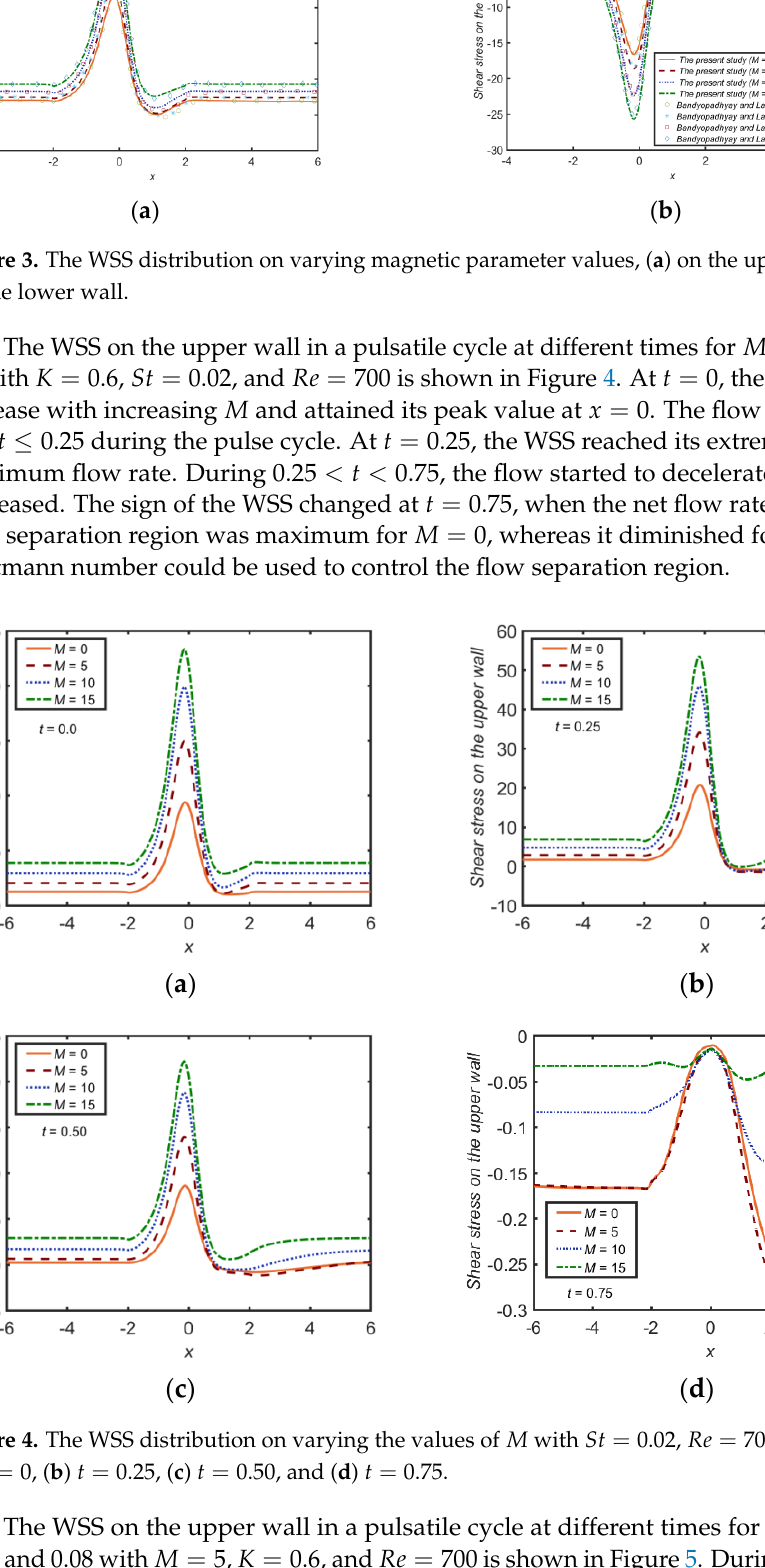
Figure 2. At (cid:1876) = 0 ( a ) the (cid:1873) profile and ( b ) the (cid:1840) profile is presented against (cid:2015) .